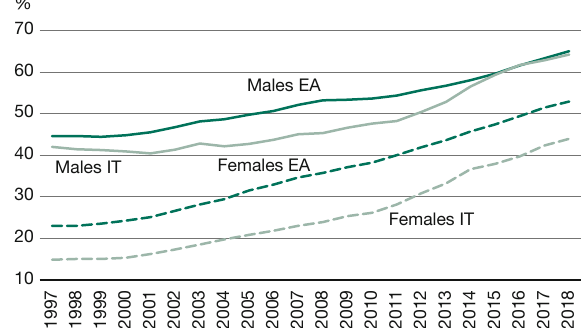
Figure 1 Employment rates of workers aged 55 to 64, Italy and euro area